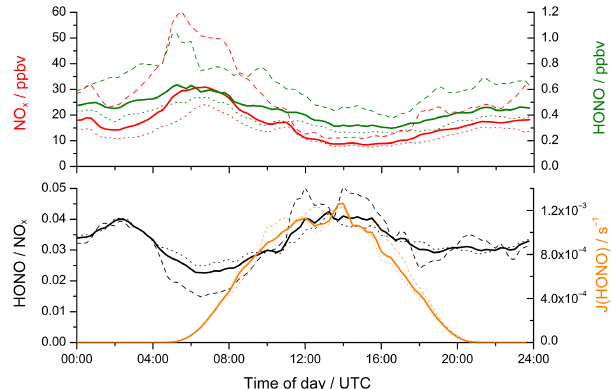
Figure 2. Average diurnal profiles of selected data from the IOP. The top panel shows total NO x (red) and HONO (green), and the bottom panel shows j (HONO) (orange) and the HONO / NO x ratio (black). Profiles were generated by binning all data in a 15 min time period together. For each, the solid line is the total of all days, the dashed line is data from easterly conditions, and the dotted line data from westerly conditions (see text for